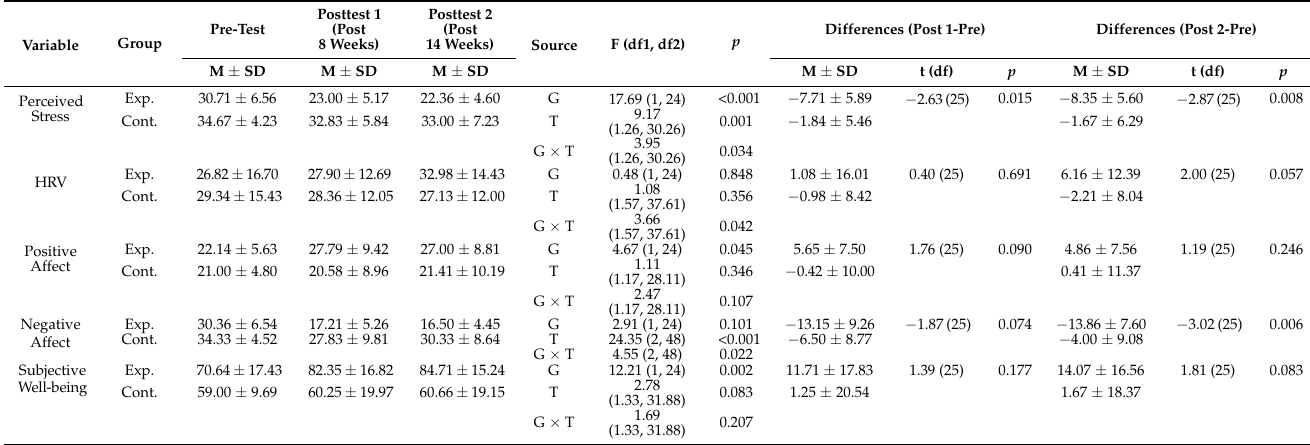
Table A1. Differences in dependent variables between groups over